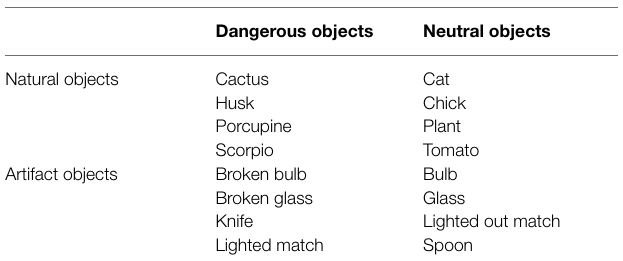
TABLE 1 | The 16 graspable